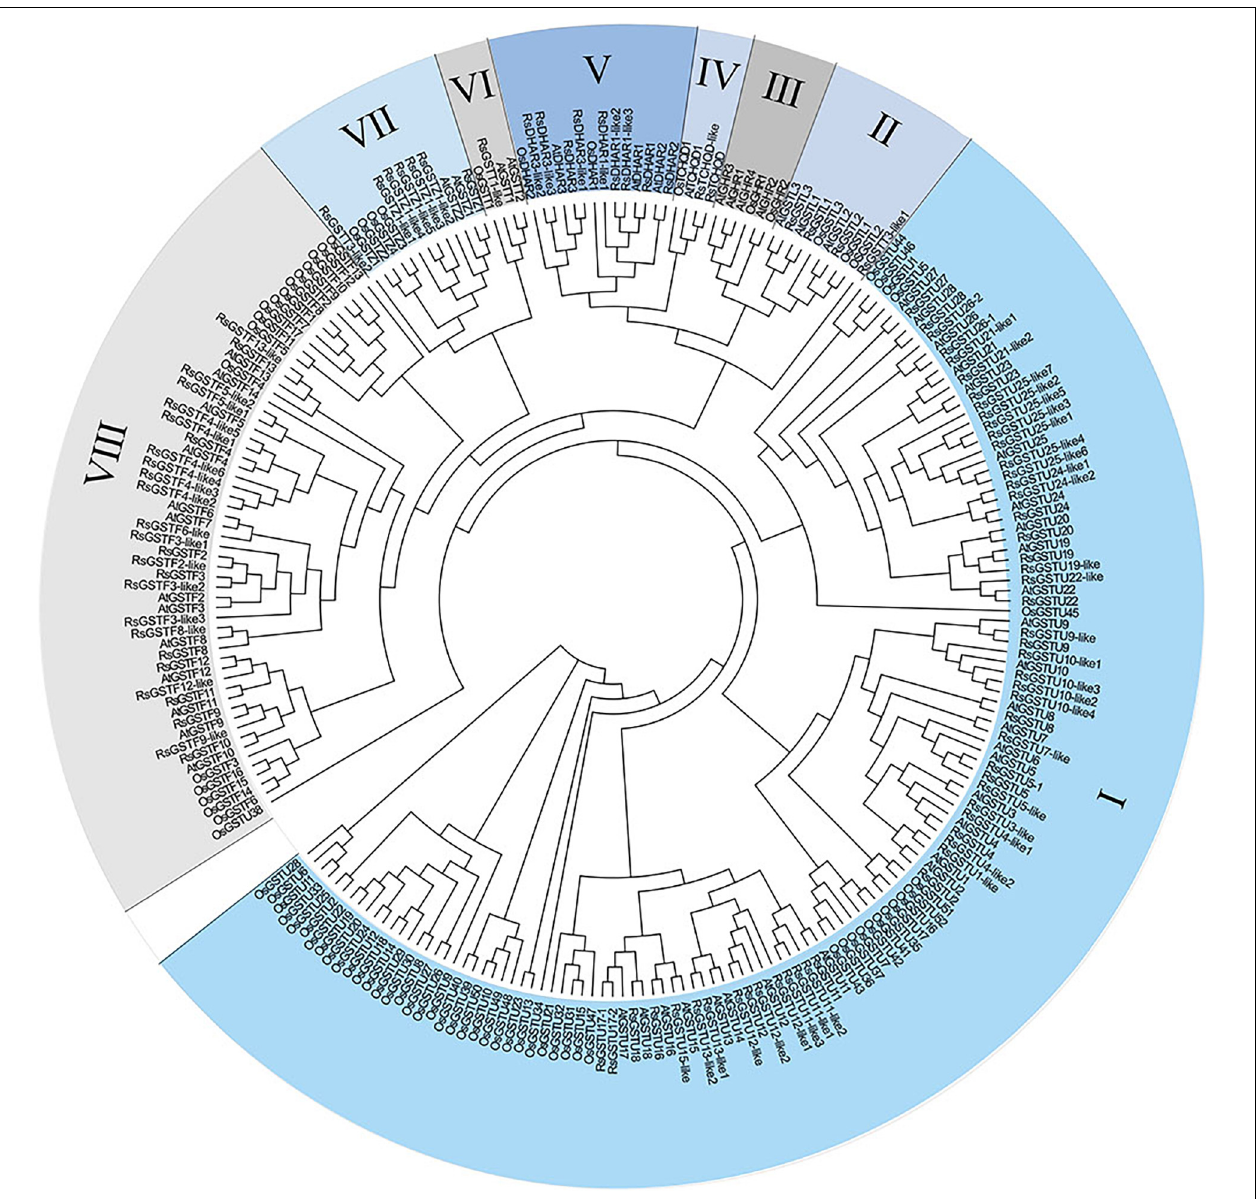
FIGURE 1 | Phylogenetic analysis of glutathione S-transferase (GST) proteins in radish, Arabidopsis, and rice plants. Their protein sequences were aligned with Clustal Omega. The phylogenetic tree was constructed using the neighbor-joining algorithm without distance corrections applied. GST proteins were divided into seven classes. The different colored parts indicate different GST groups. I–VIII represent the tau, lambda, GHR, DHAR, theta, zeta, and phi subfamilies, respectively.